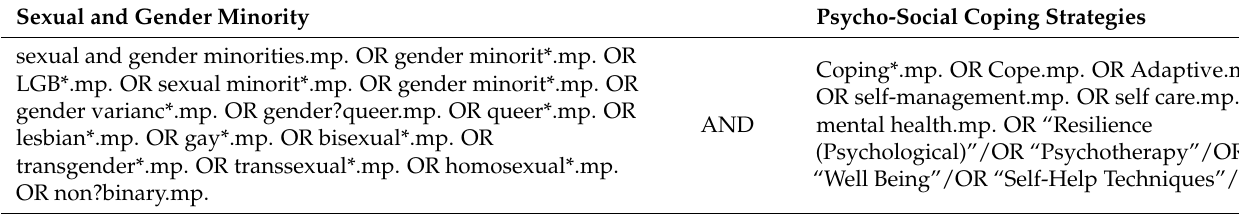
Table A3. PsycInfo search